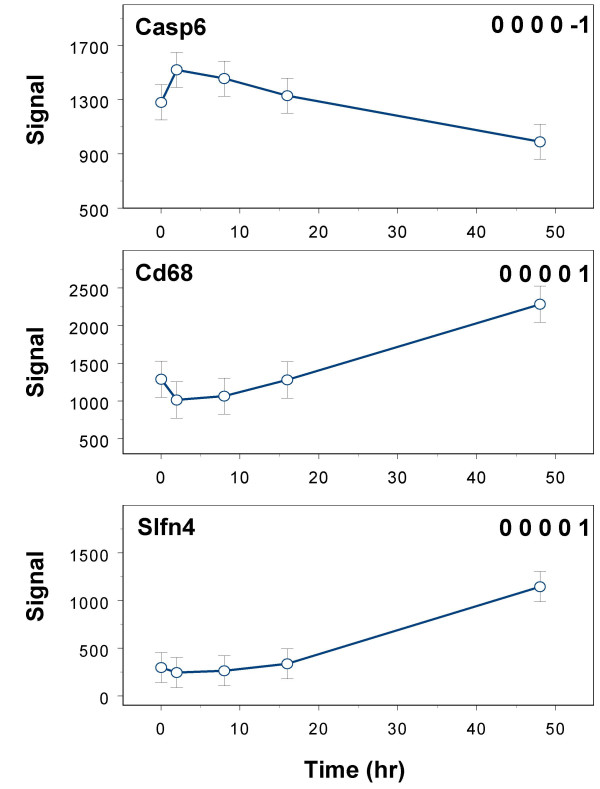
Example diagrams to illustrate expression patterns of genes in Class IV. Expression patterns of genes Casp6, Cd68 and Slfn4 from Class IV, were unchanged until the last time point sampled, 48 hr after OBX.